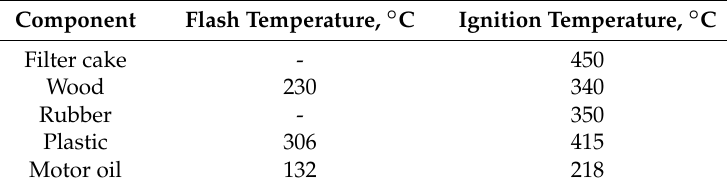
Table 3. Flash temperature and ignition temperature of fuel components.